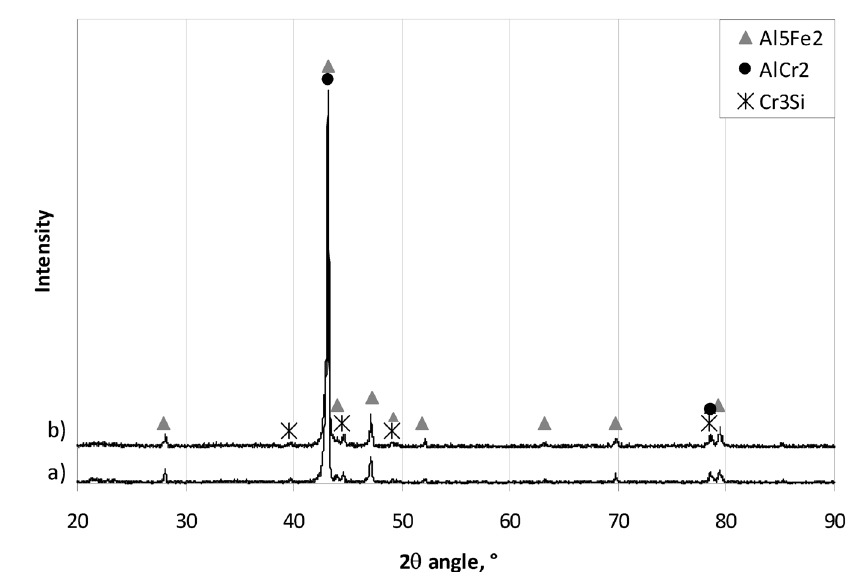
Figure 5. XRD spectra for unexposed aluminized specimens. a) P91. b) HCM12A.